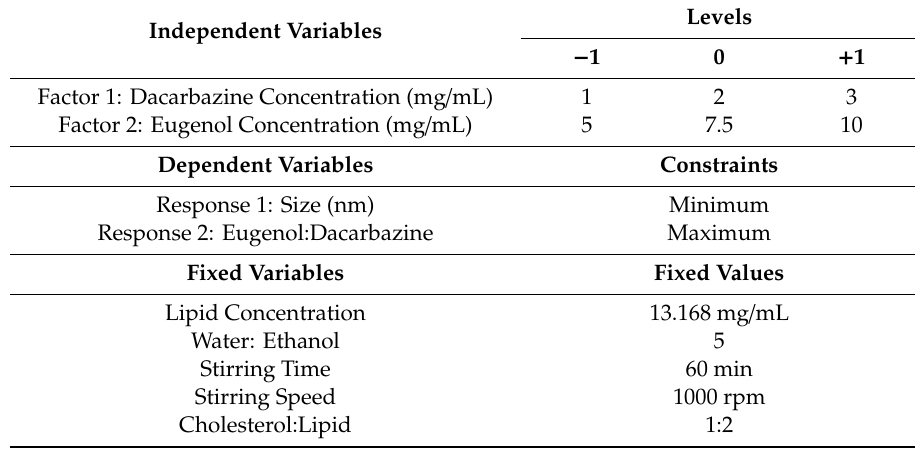
Table 3. DOE Variables (Second